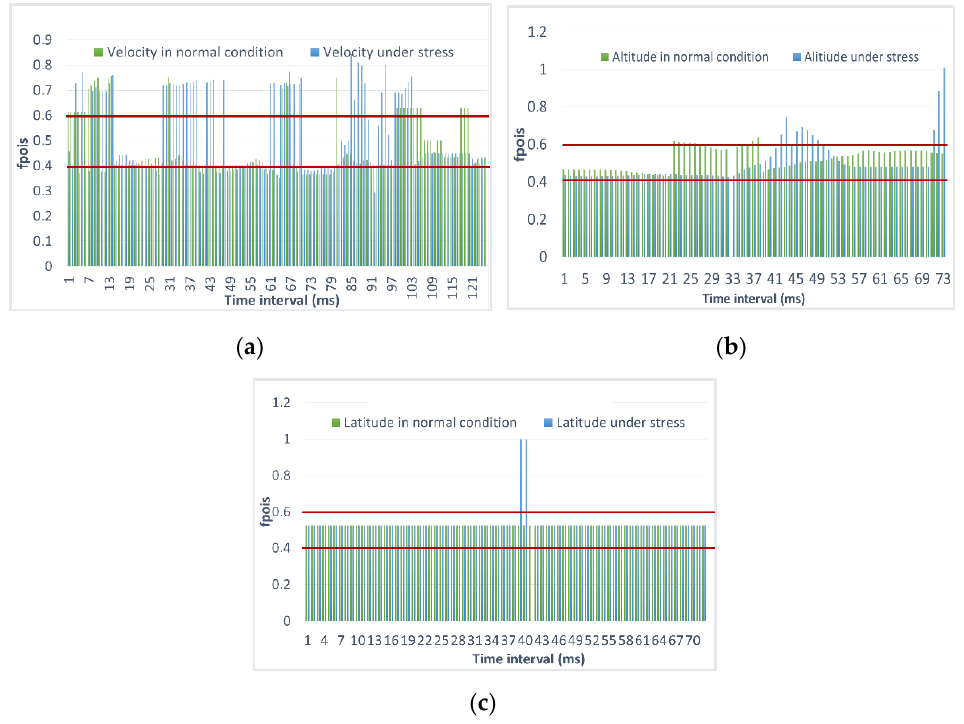
Figure 12. Evaluation of Metric 2 during flight in mission mode under normal and stress conditions for ( a ) flight speed; ( b ) flight altitude; ( c ) flight latitude.